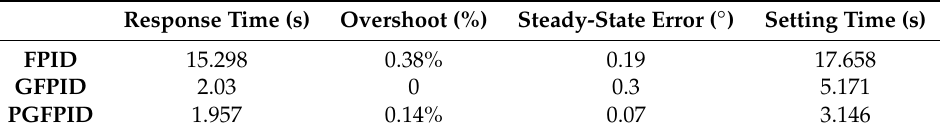
Figure 9. ( a ) FPID without friction; ( b ) step responses; ( c ) step response amplification; ( d ) steady-state error. Table 8. Response index of control.